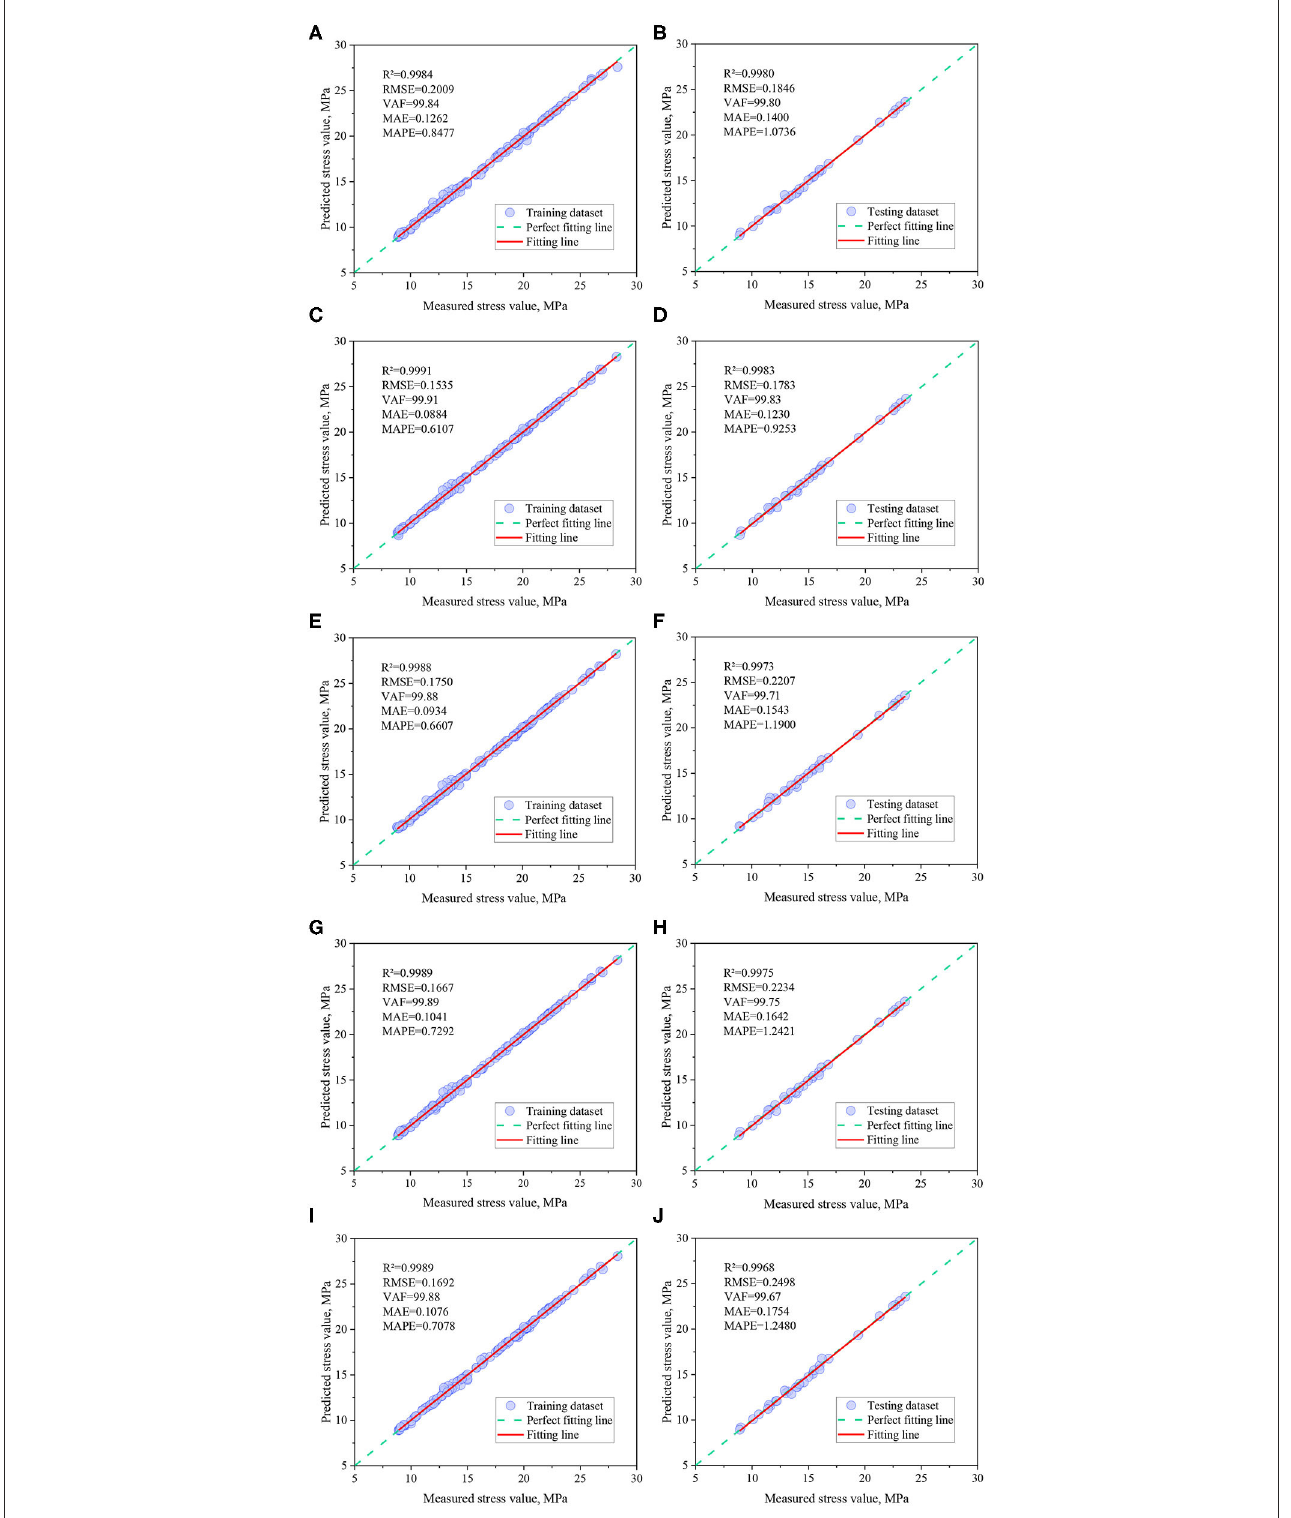
FIGURE7 Correlation analysis between measured and predicted induced stress. (A) SSA-BP (Training). (B) SSA-BP (Testing). (C) GWO-BP (Training). (D) GWO-BP (Testing). (E) BOA-BP (Training). (F) BOA-BP (Testing). (G) TSA-BP (Training). (H) TSA-BP (Testing). (I) MVO-BP (Training). (J) MVO-BP (Testing).